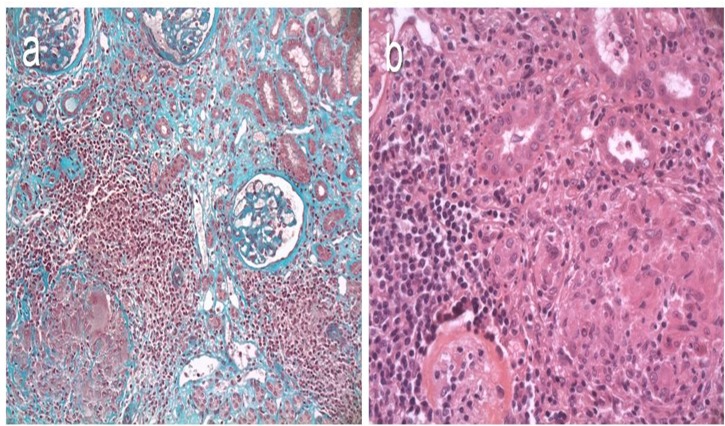
Representative cases of interstitial granulomas.(a) Case 4. Masson trichrome. Interstitial epithelioid and gigantocellular non-necrotizing granuloma, surrounded by lymphocytes. Original magnification, X 20. (b) Case 6. Hematoxylin and eosin staining. Granuloma associated with severe diffuse CLL/SLL monomorphic infiltrate. Original magnification, X 40.